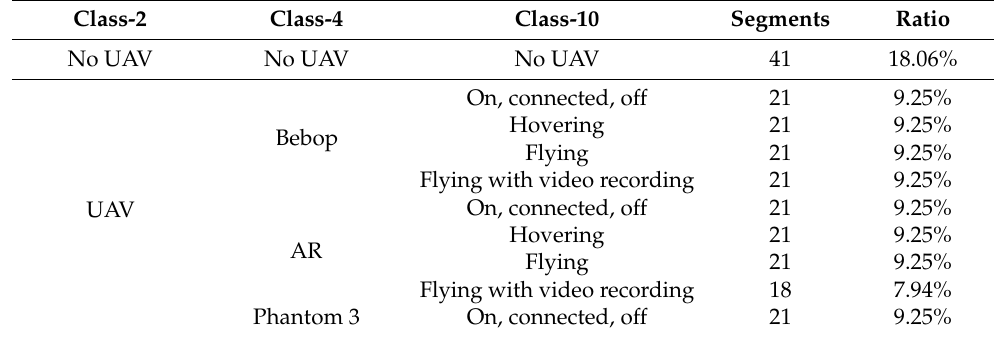
Table 3. Composition of Drone-RF